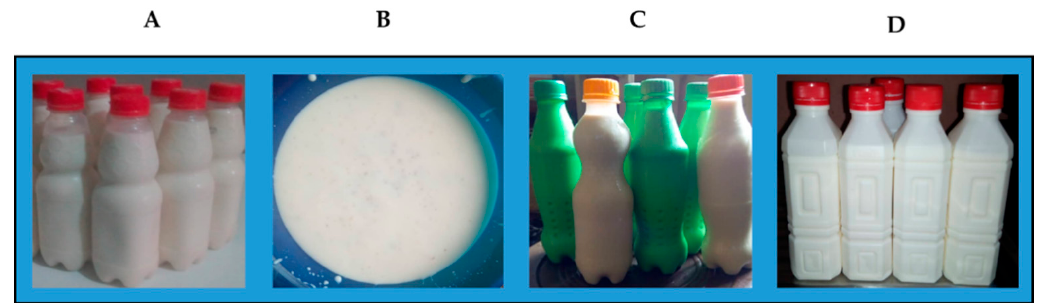
Figure 1. Traditional milk products found in Nigeria. Soymilk ( A )—plant-based, nono ( B )—animal- based, and tiger nut milk ( C )—plant-based. The unregulated yoghurt ( D ) could be any type of